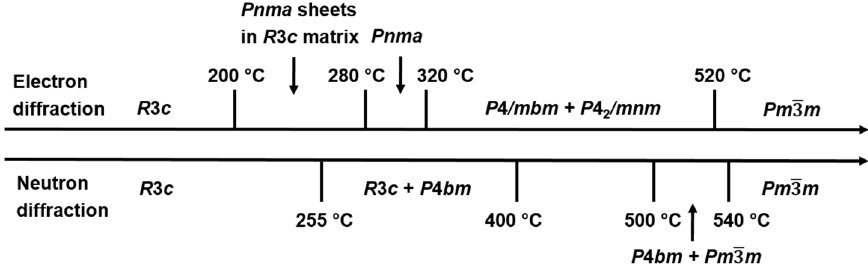
Figure 2. Reported possible phase transition routes based on TEM and X ‐ ray/neutron diffraction studies (data from references [29,68,69]).